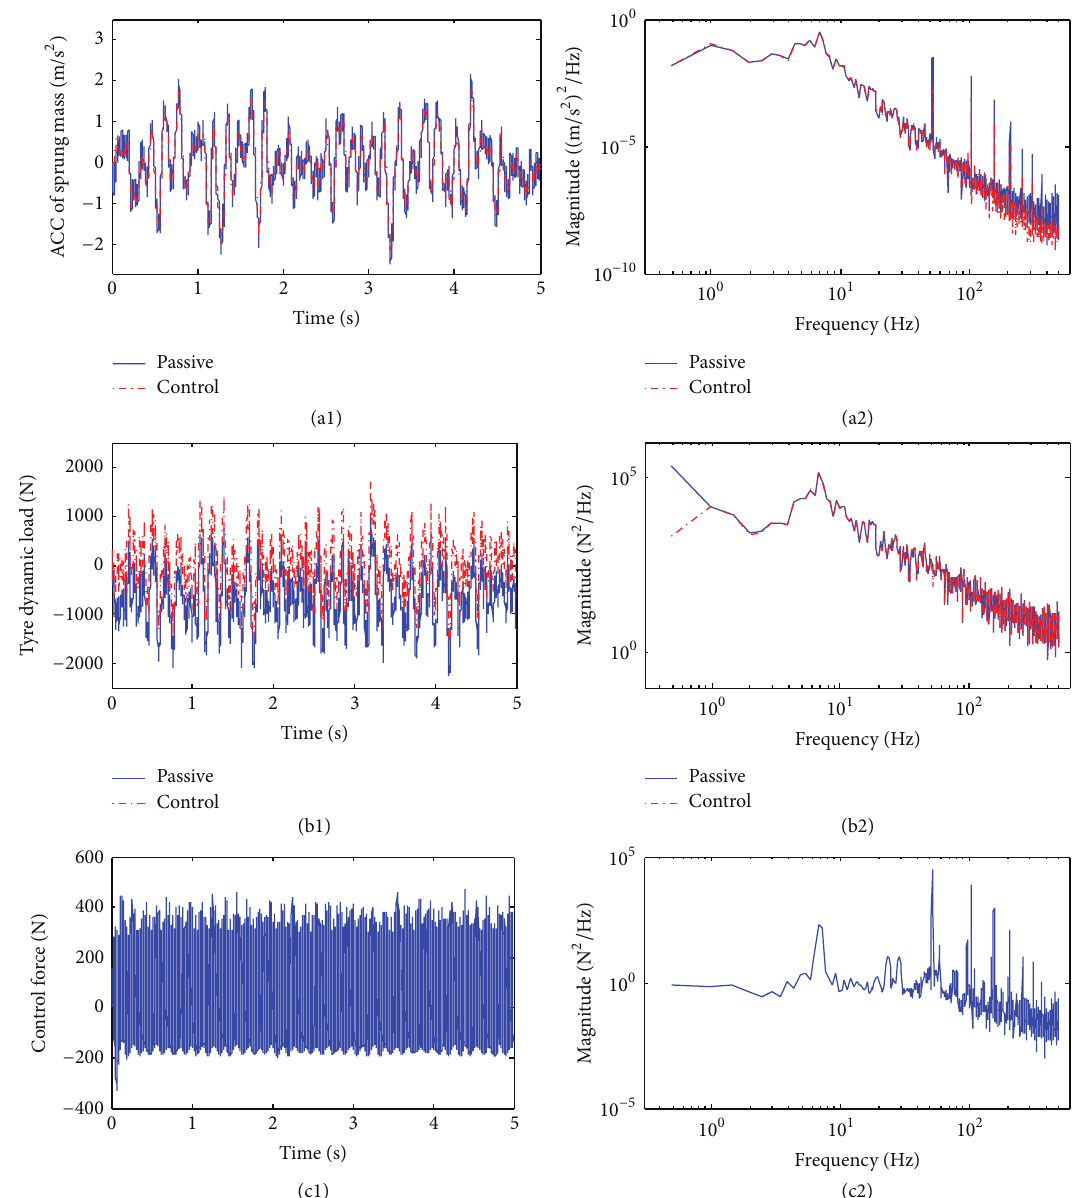
Figure 15: Suspension performance under LMS control at velocity 60 km/h. (a1) Time history of sprung mass acceleration. (a2) PSD of sprung mass acceleration. (b1) Time history of tyre dynamic load. (b2) PSD of tyre dynamic load. (c1) Time history of suspension control force. (c2) PSD of suspension control force.